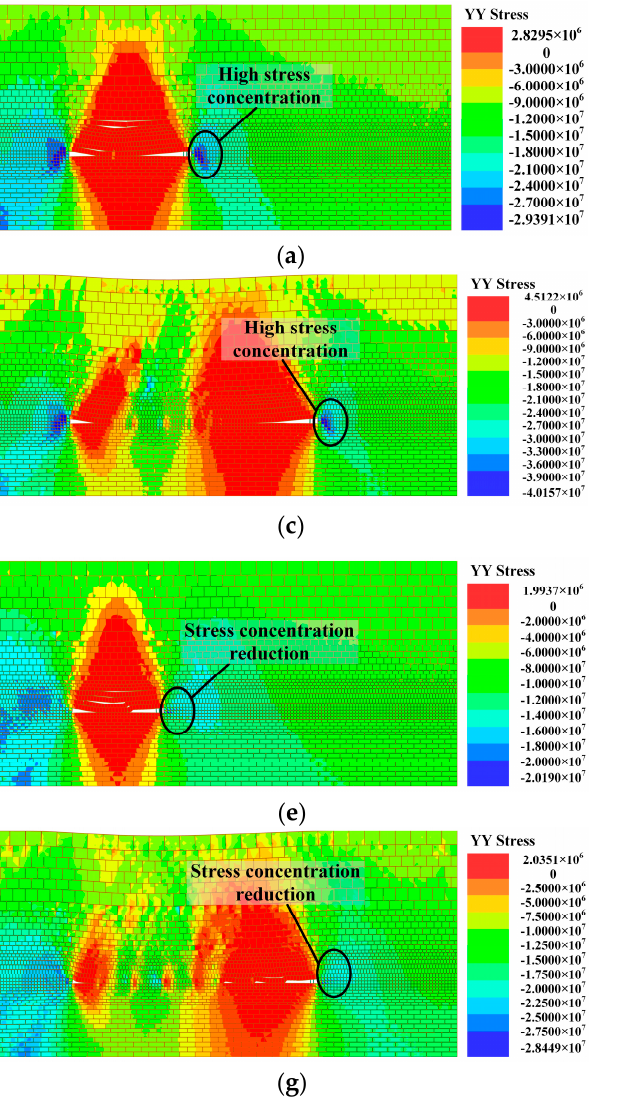
( d ) Figure 11. Displacement cloud image after cutting the roof: ( a ) is the displacement state when the working face is first broken after cutting the roof; ( b ) is the displacement state when the working face is excavated for 120 m after cutting the roof; ( c ) is the displacement state when the working face is excavated for 160 m after cutting the roof; and ( d ) is the displacement state when the working face is excavated for 200 m after cutting the roof. 5.2. Stress Analysis As is shown in Figure 12a–d, the thick hard roof was not treated, and the stress con-